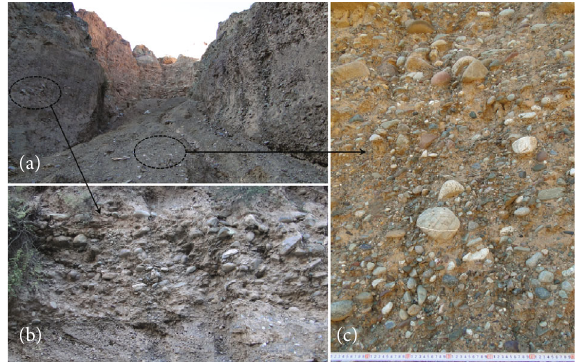
Figure 1: General gravelly soil in situ: (a) overview of a project; (b) gravel-soil mixture in a local steep slope; (c) the second spot of gravel-soil